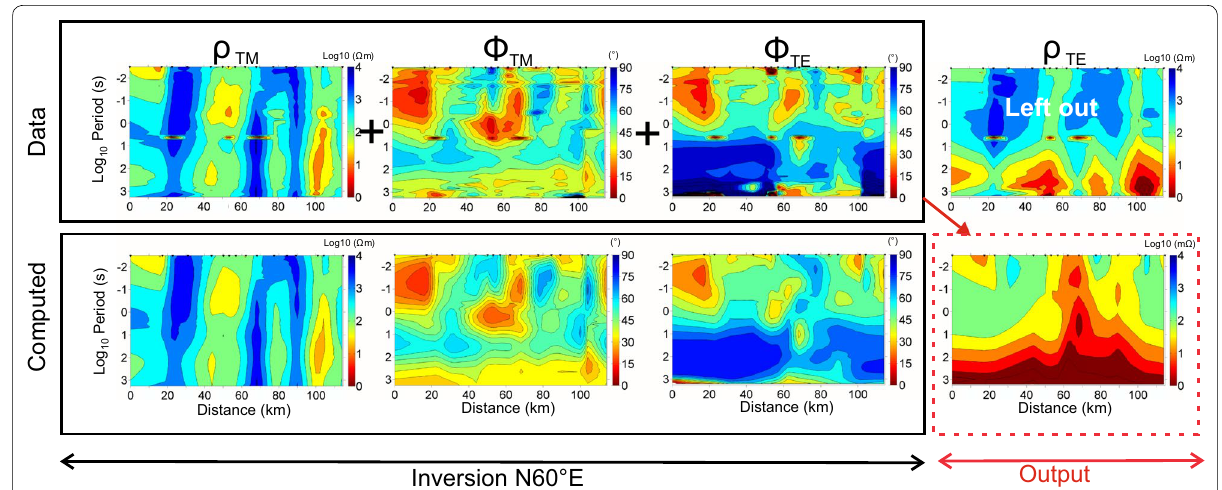
Fig. 5 Fit to the data for a strike direction of 60° or N60°E. The upper images are the data pseudo‑sections and the ones below are the corresponding responses of the model. Notice that the pseudo‑sections of the TE apparent resistivity look more alike than the corresponding ones of this figure. The other three pairs indicate a good fit to the data. The TE apparent resistivity was not part of the inversion